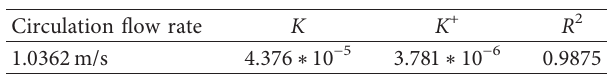
Figure 8: Comparison of the predicted and measured extraction